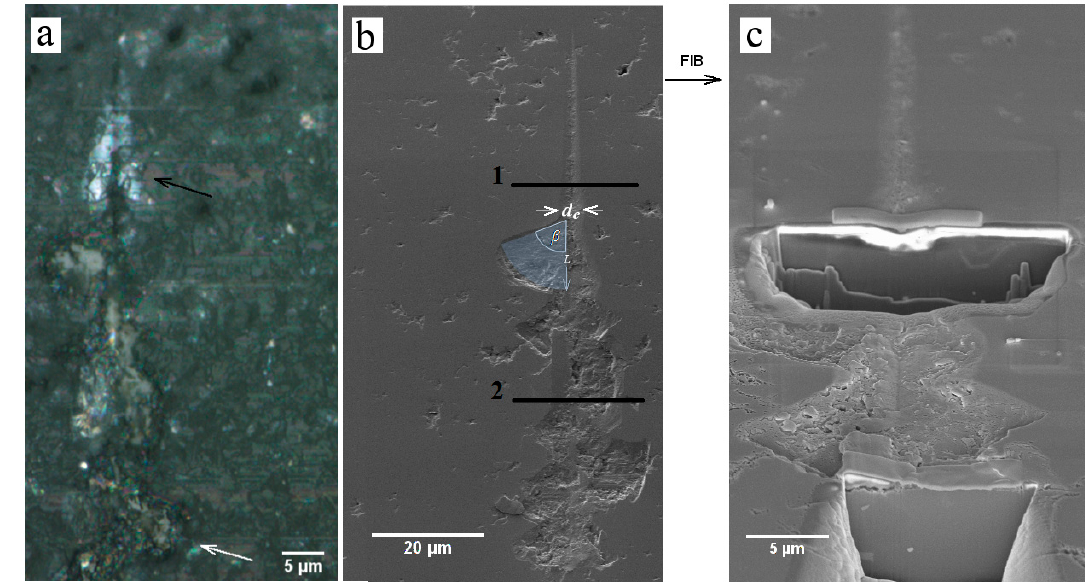
Figure 4. ( a ) Optical micrograph showing one of the high-load scratches; the main damage events are indicated by arrows. Surface SEM images of a high load nanoscratch ( b ) before and ( c ) after the FIB sectioning process.